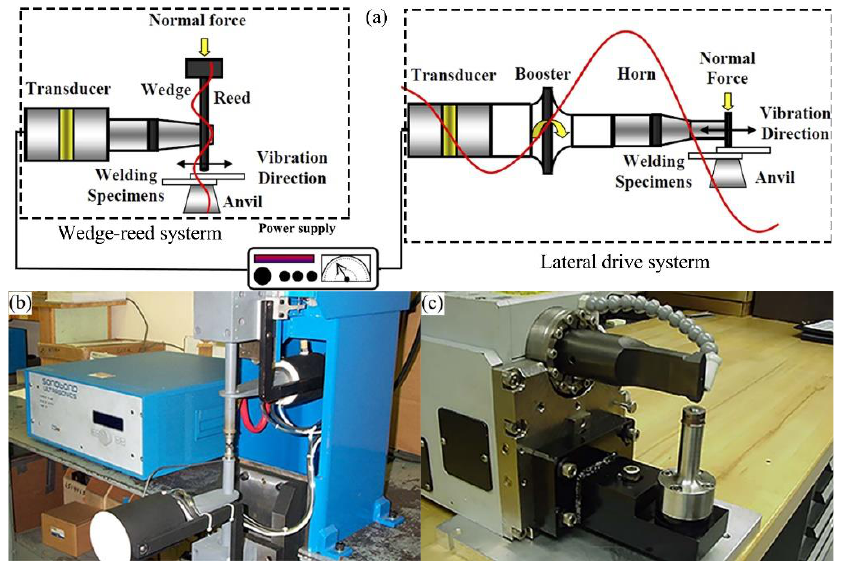
Figure 4. ( a ) Schematic diagram of the USW [30]; ( b ) The wedge-reed welder; ( c ) The lateral drive